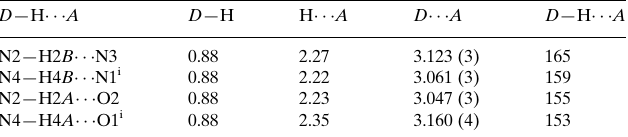
Hydrogen-bond geometry (A˚ , (cid:3)